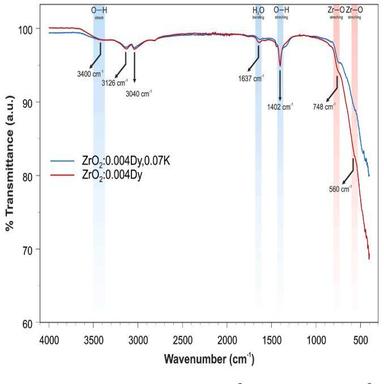
FTIR spectra of ZrO2:0.004Dy3+ and ZrO2:0.004Dy3+, 0.07K+ phosphors.